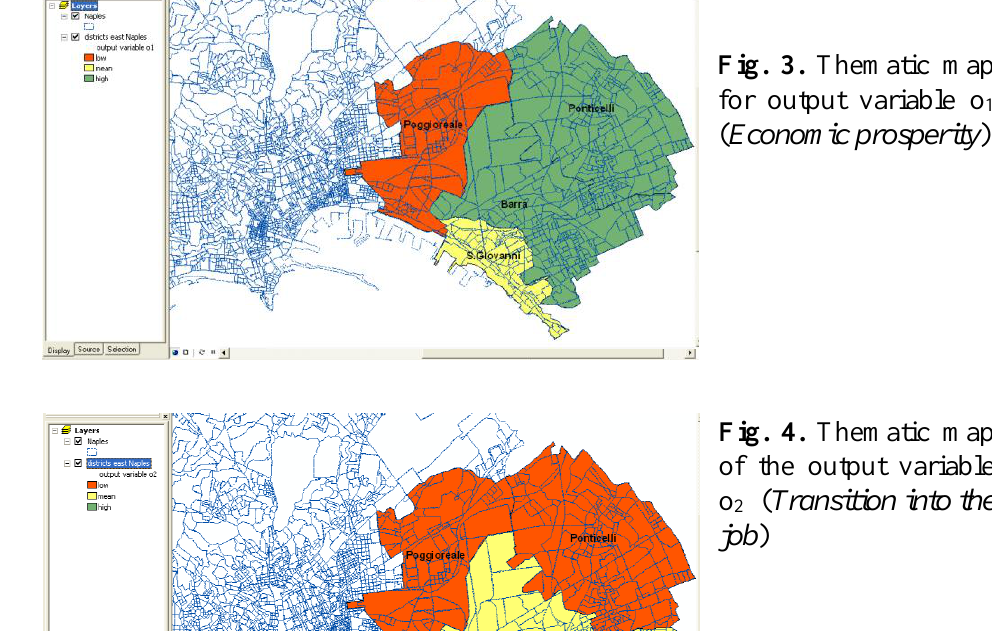
Fig. 4. Thematic map